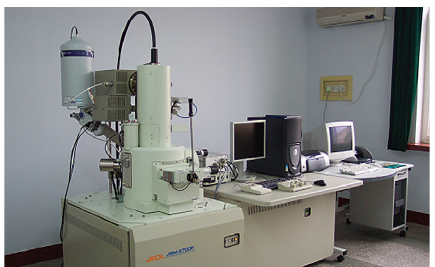
Figure 6: Scanning electron microscopy of